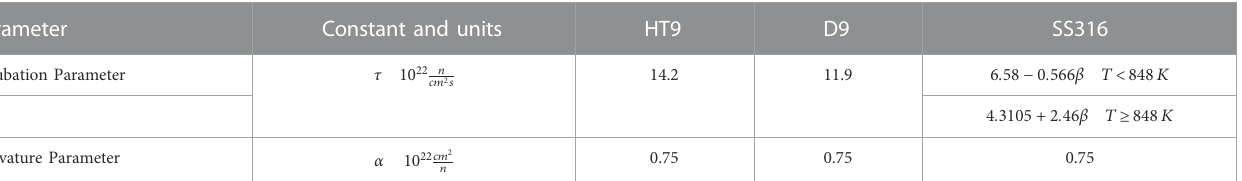
TABLE 1 Swelling constants and units.